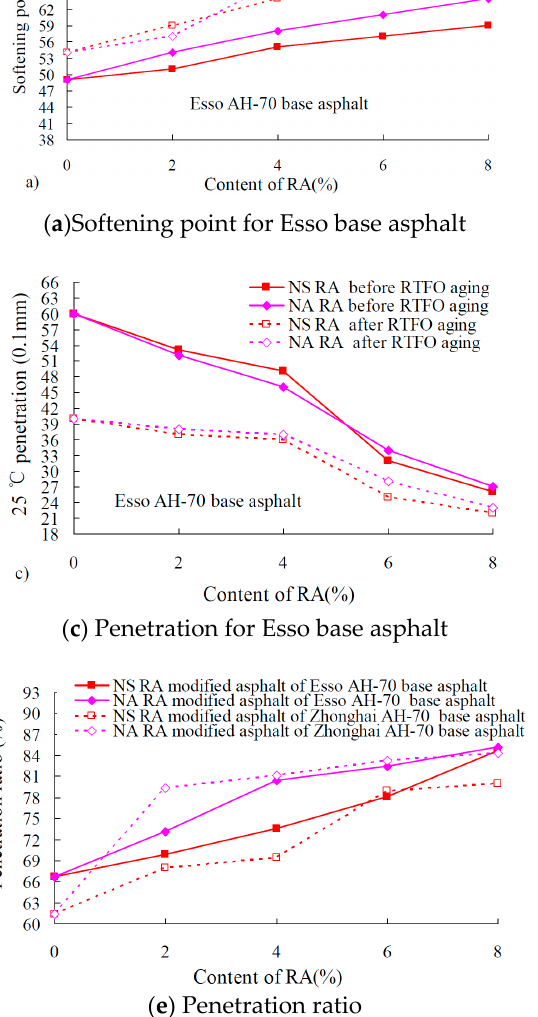
Figure 2. Index test results of the RA-modified asphalt.